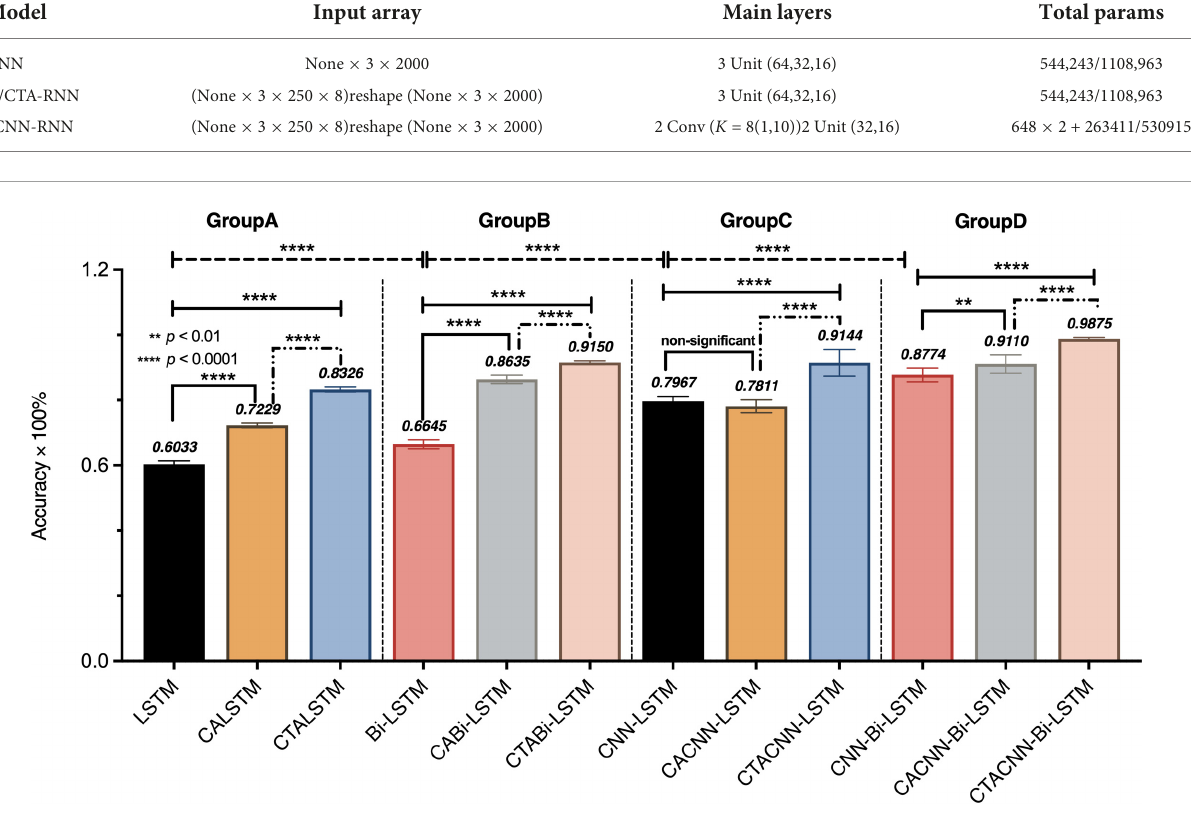
TABLE 6 Array and total parameters of 3s-dataset (OCER) fed into different models.